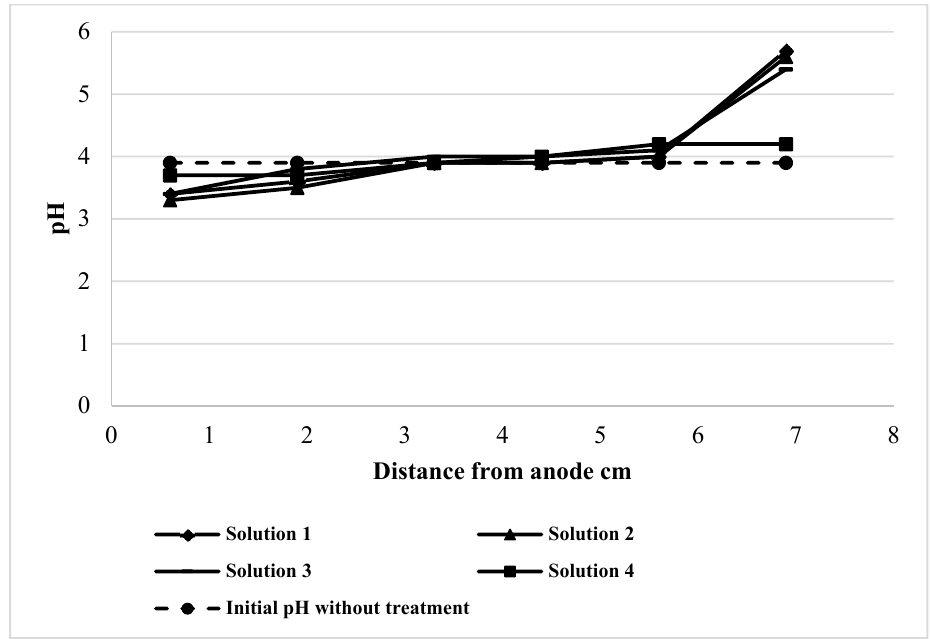
Figure 4. pH evolution from anode to cathode after electrodialytic remediation.